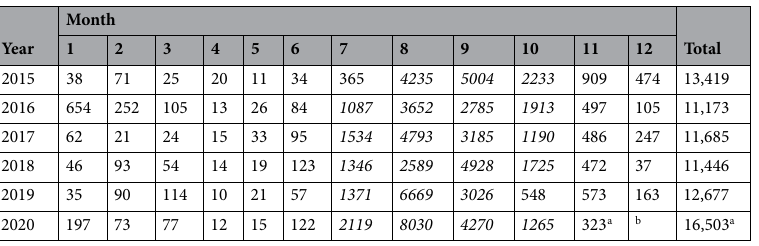
Table 1. The number of total active fires in the Amazonian basin detected by satellite during the last five years 8 . Fire occasions that exceeded 1000 are marked in italics. a The latest available data at the time of publication. b Data not available at the time of